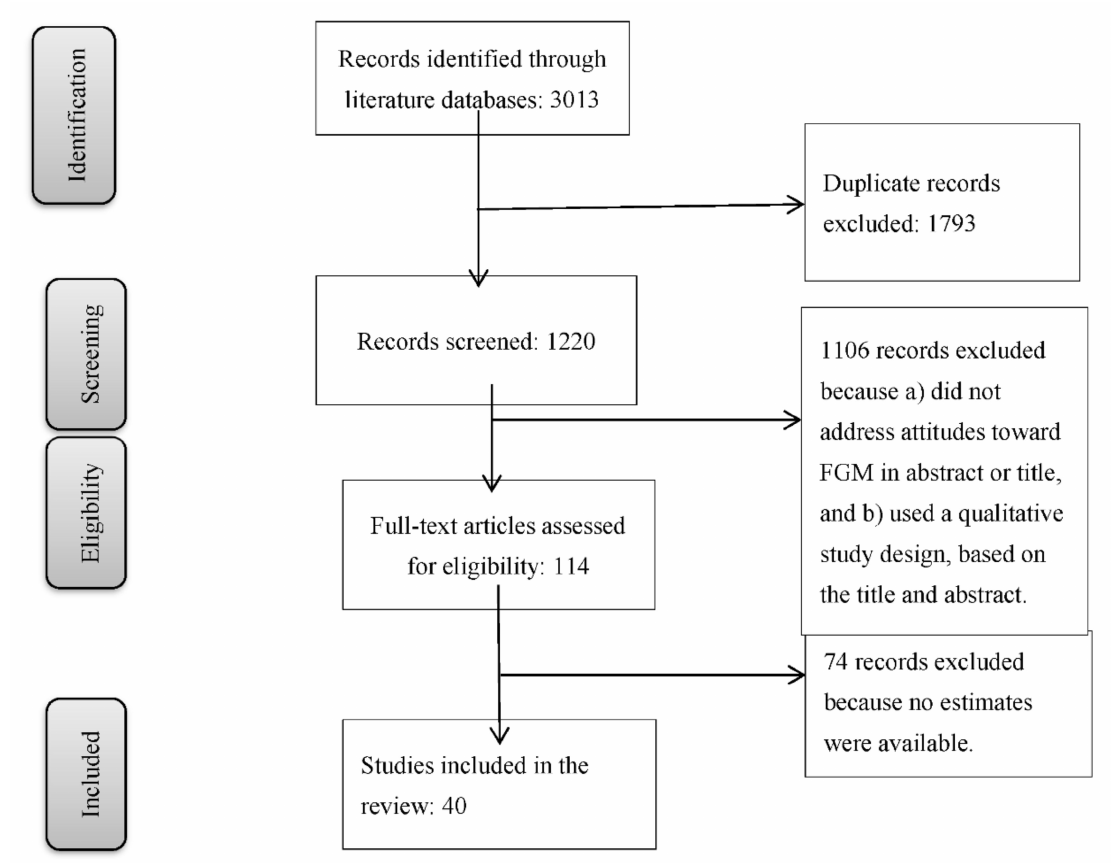
Figure 1. Number of articles eligible for the